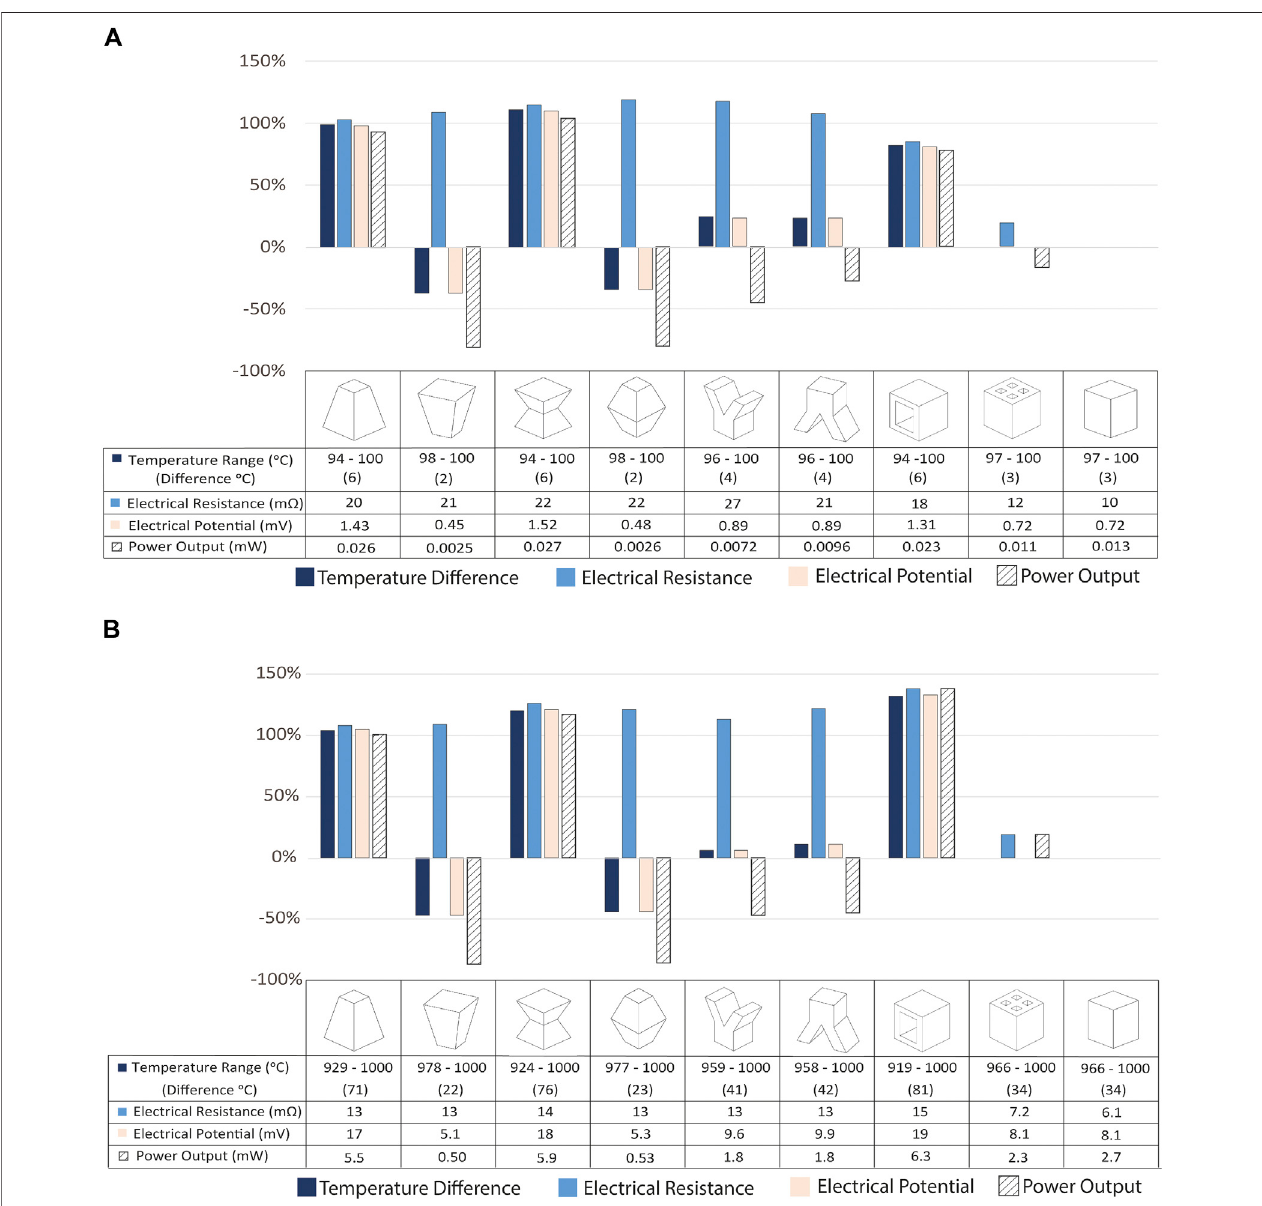
FIGURE 5 | The percent change in the temperature range across each leg, the leg electrical resistance and potential, and maximum power generation potential comparedtothoseforarectangular(conventional)shapedlegareshownforconstanthotsidetemperature( T h )andcoldsidenaturalconvectionboundaryconditionsfor (A) (Bi 0.5 Sb 0.5 ) 2 Te 3 ( T h (cid:1) 100 C) and (B) Si 0.78 Ge 0.22 ( T h (cid:1) 1,000 C) legs of varying shapes. The tables below the plots show the computed values of the performance metrics.